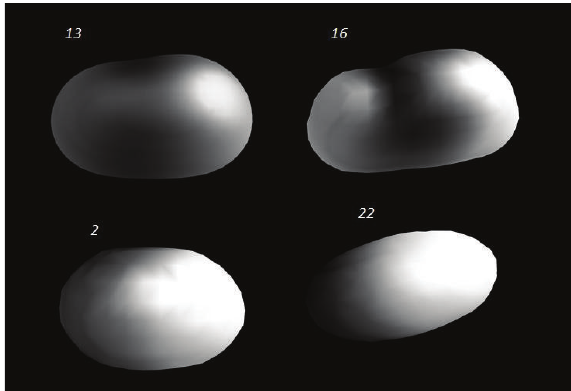
Table 2: Binding energy ( 𝐸